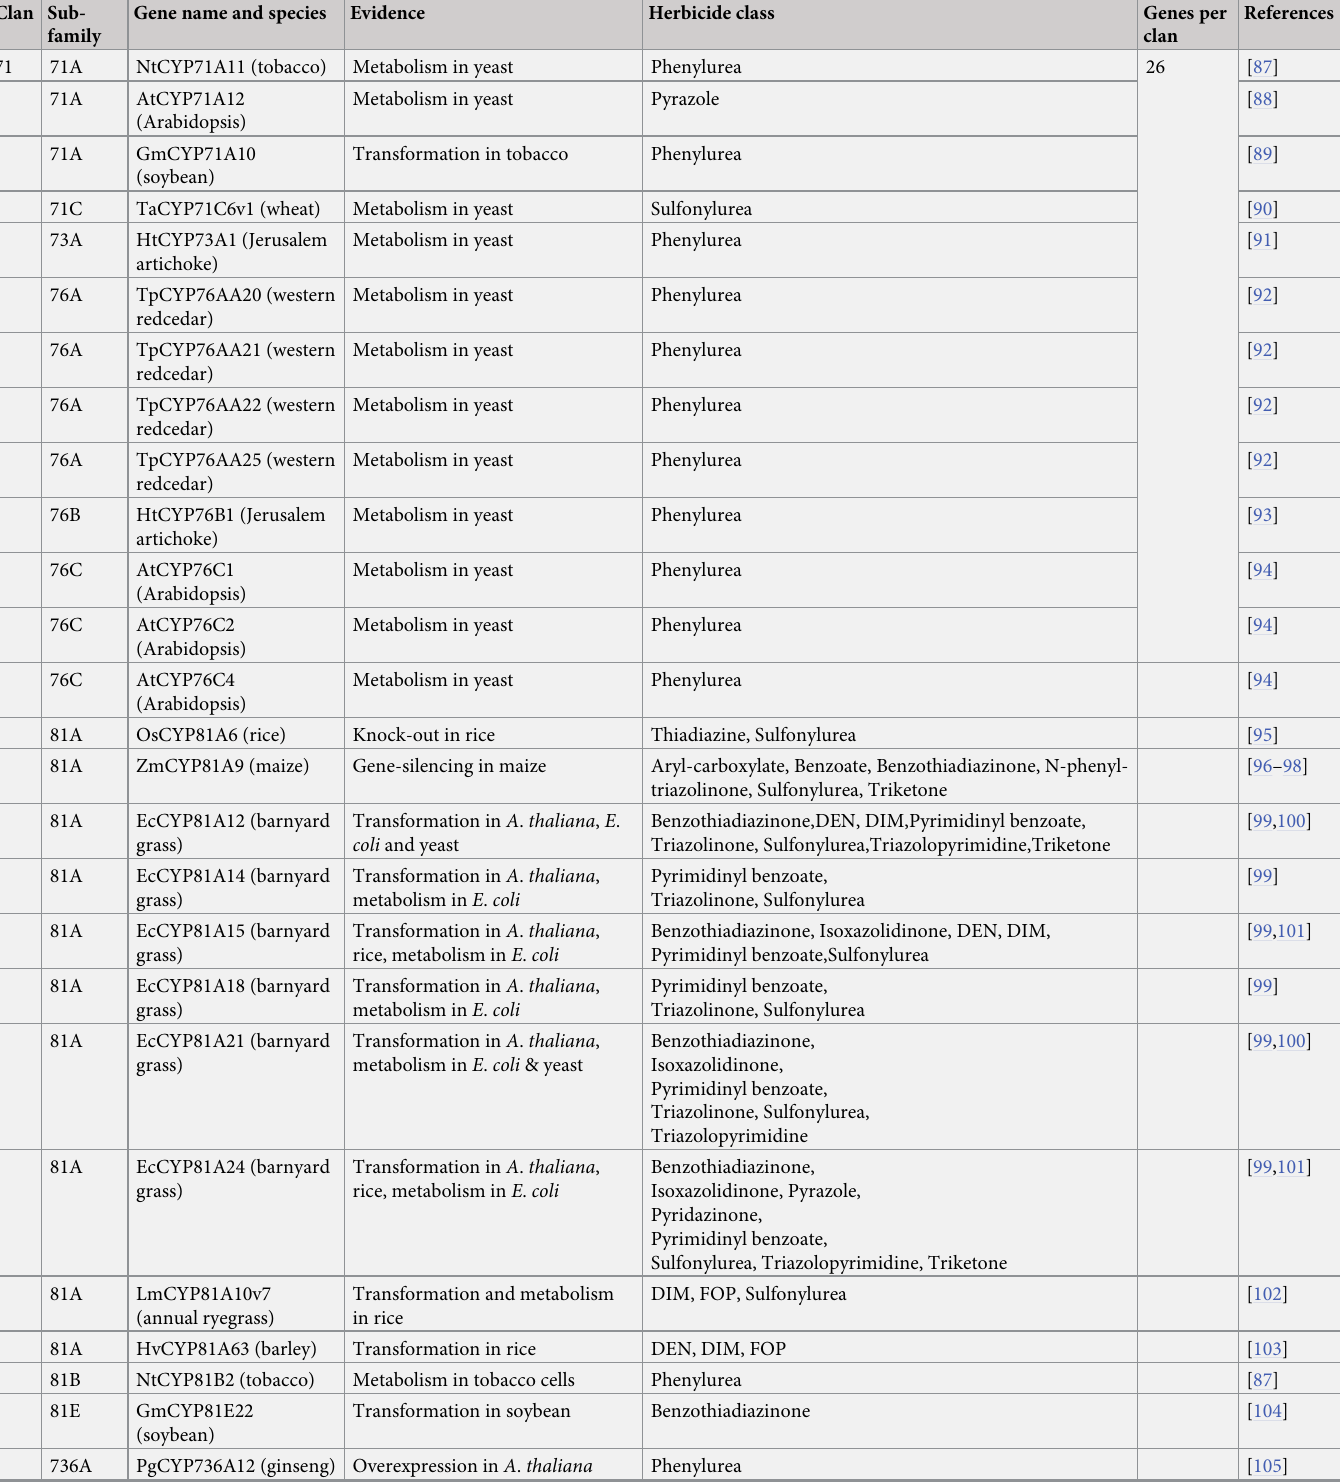
Table 2. Plant CYPs that metabolise or confer resistance or tolerance to herbicides are found within clans 71 and 72. Table adapted from [11]. Gene numbers from this table are shown in Fig